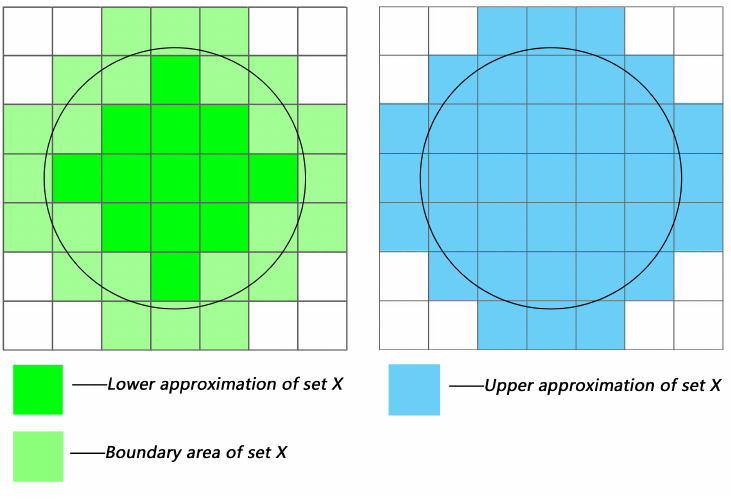
Figure 1. Rough set